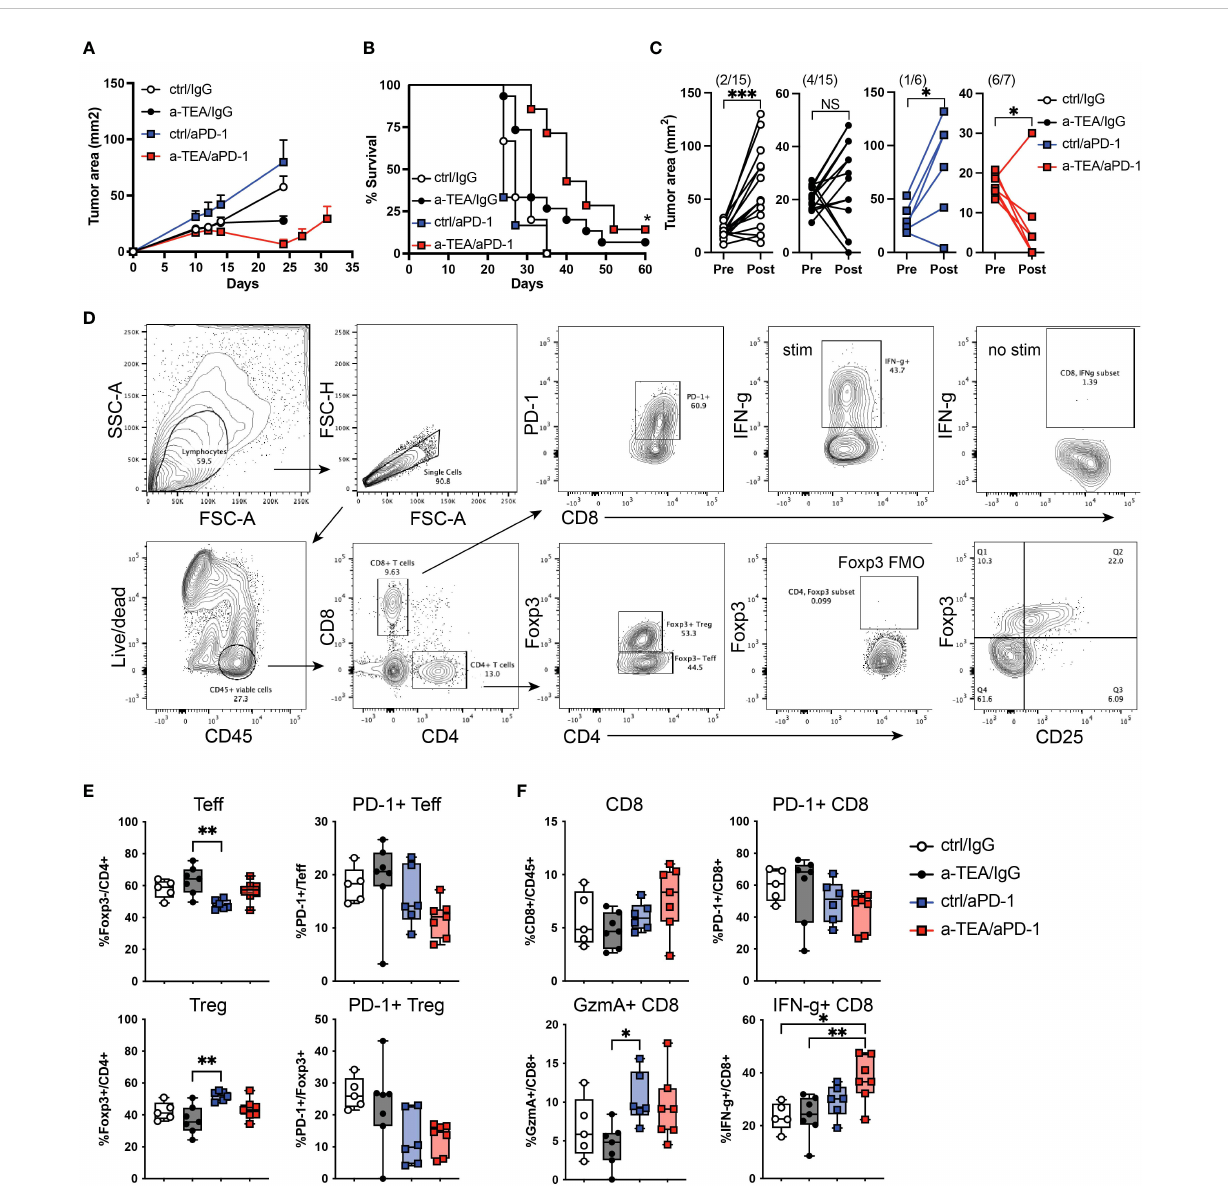
FIGURE 1 Increased tumor regression and improved survival following a-TEA-LS plus aPD-1 ICB in mice with mammary carcinoma. (A-C) 4T1 mammary carcinoma tumor-bearing mice were treated with control diet, IgG (ctrl Ab), a-TEA-LS, and/or aPD-1 and then (A) tumor growth (mean+SD) and (B) survival were determined. *P<0.05 by Log-rank test. (C) Maximum change in tumor size was determined pre- and post-treatment in the indicated treatment groups. Each dot represents an individual mouse. The total number of mice per cohort exhibiting a reduction in tumor size (post-treatment) is depicted in parentheses. *P<0.05, ***P<0.001 by paired t test. (D-F) Flow cytometry analysis of tumors from 4T1 tumor-bearing mice. (D) Representative fl ow cytometry graphs from 4T1 tumor-bearing mice treated as in Figure 1A. Seven days after the start of treatment, tumors were harvested for analysis by fl ow cytometry. (E, F) Graphs depicts the frequency of Foxp3 - CD4 + Teff, Foxp3 + CD4 + Treg, and CD8 + T cells within the tumor and the extent of PD-1 and IFN- g expression (mean and range of n=7 mice/group). *P<0.05, **P<0.01 by 1-way ANOVA. NS, not signi fi